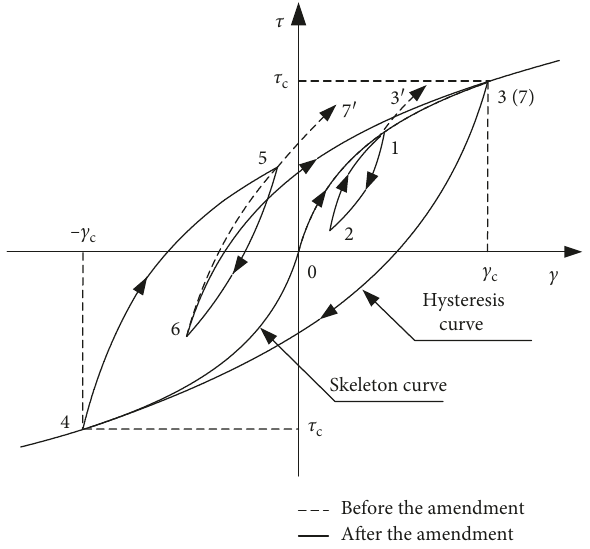
Figure 10: Stress-strain curves of modified Davidenkov model under irregular loading and